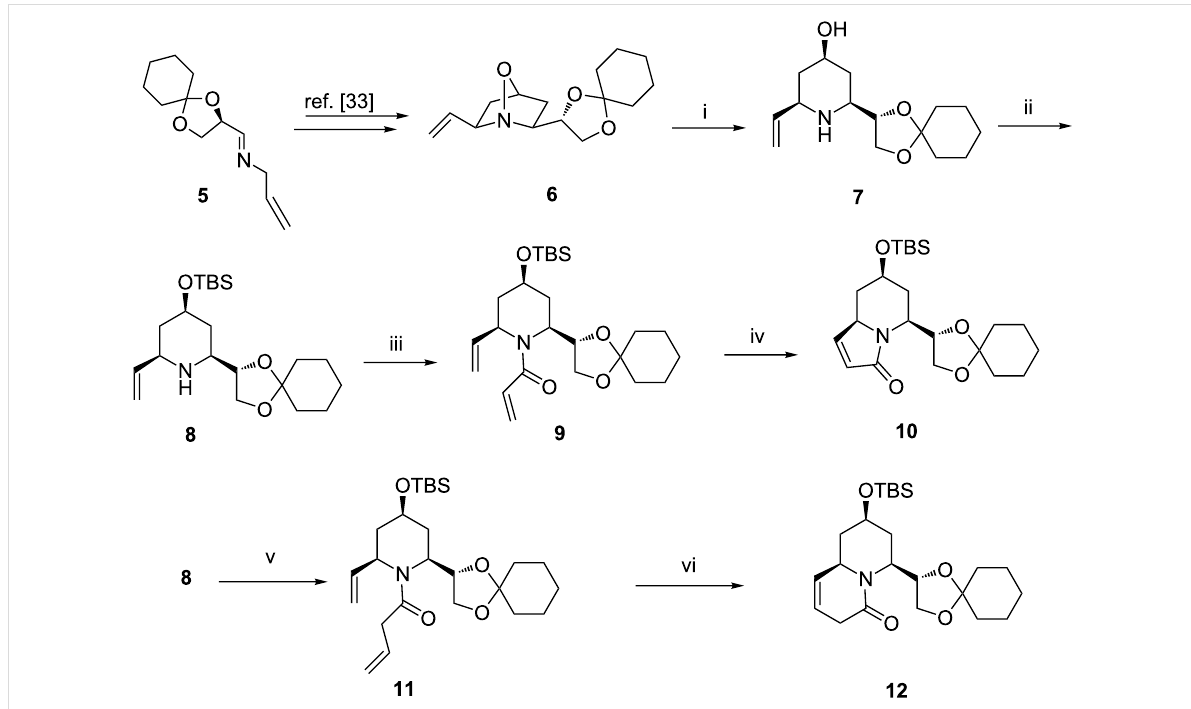
Scheme 1: Reagents and conditions: (i) Zn/AcOH, rt, 1 h, 86%. (ii) TBSOTf, DIPEA, CH 2 Cl 2 , − 5 °C, 1 h, 91%. (iii) Acrylic acid, EDC, HOBt, NMM, CH